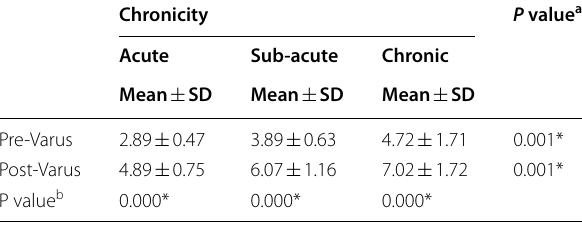
Table 4 MME Measurement according to chronicity